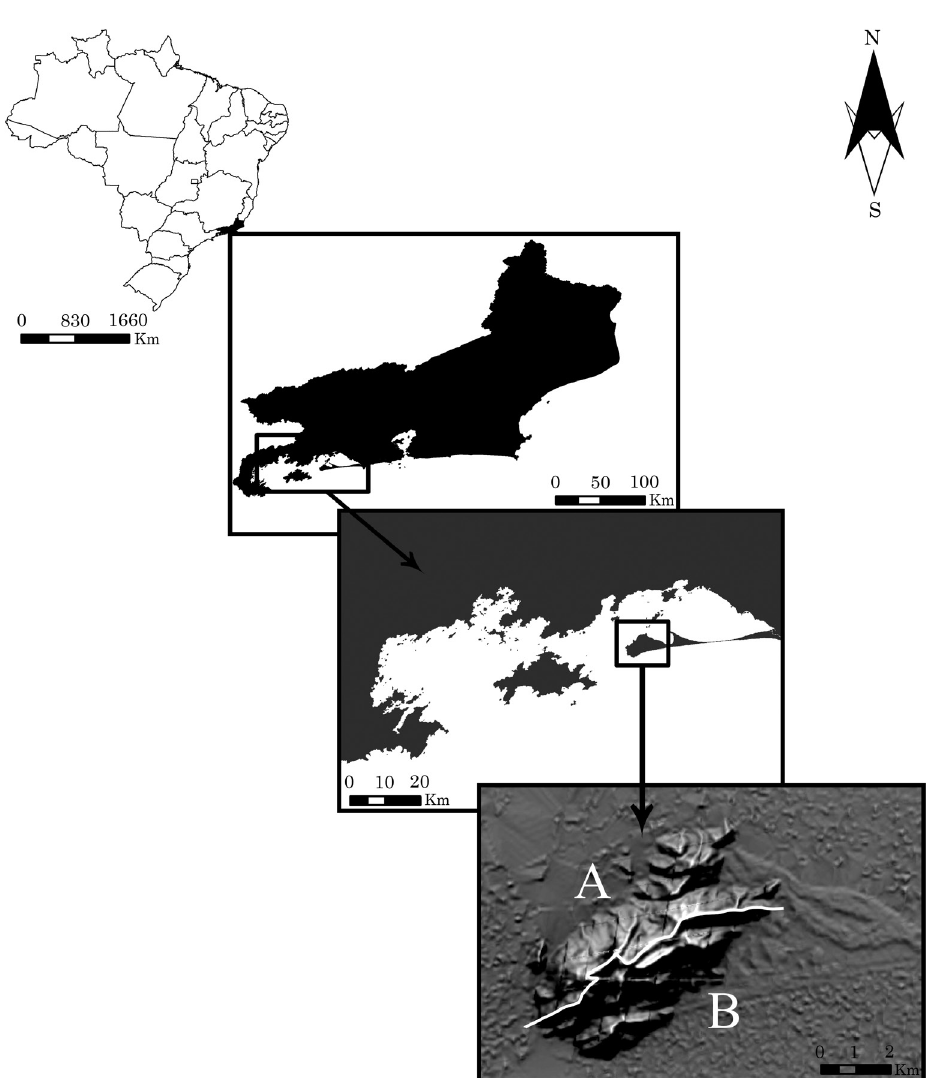
figure 1. location of Marambaia island in the southern region of the state of rio de Janeiro. Sampling sites a and b are distinguished in the lower right corner image by a white line drawn across the higher topographical ridge of the area. this image also indicates overall differences of incident solar radiation, where darker areas intercept less